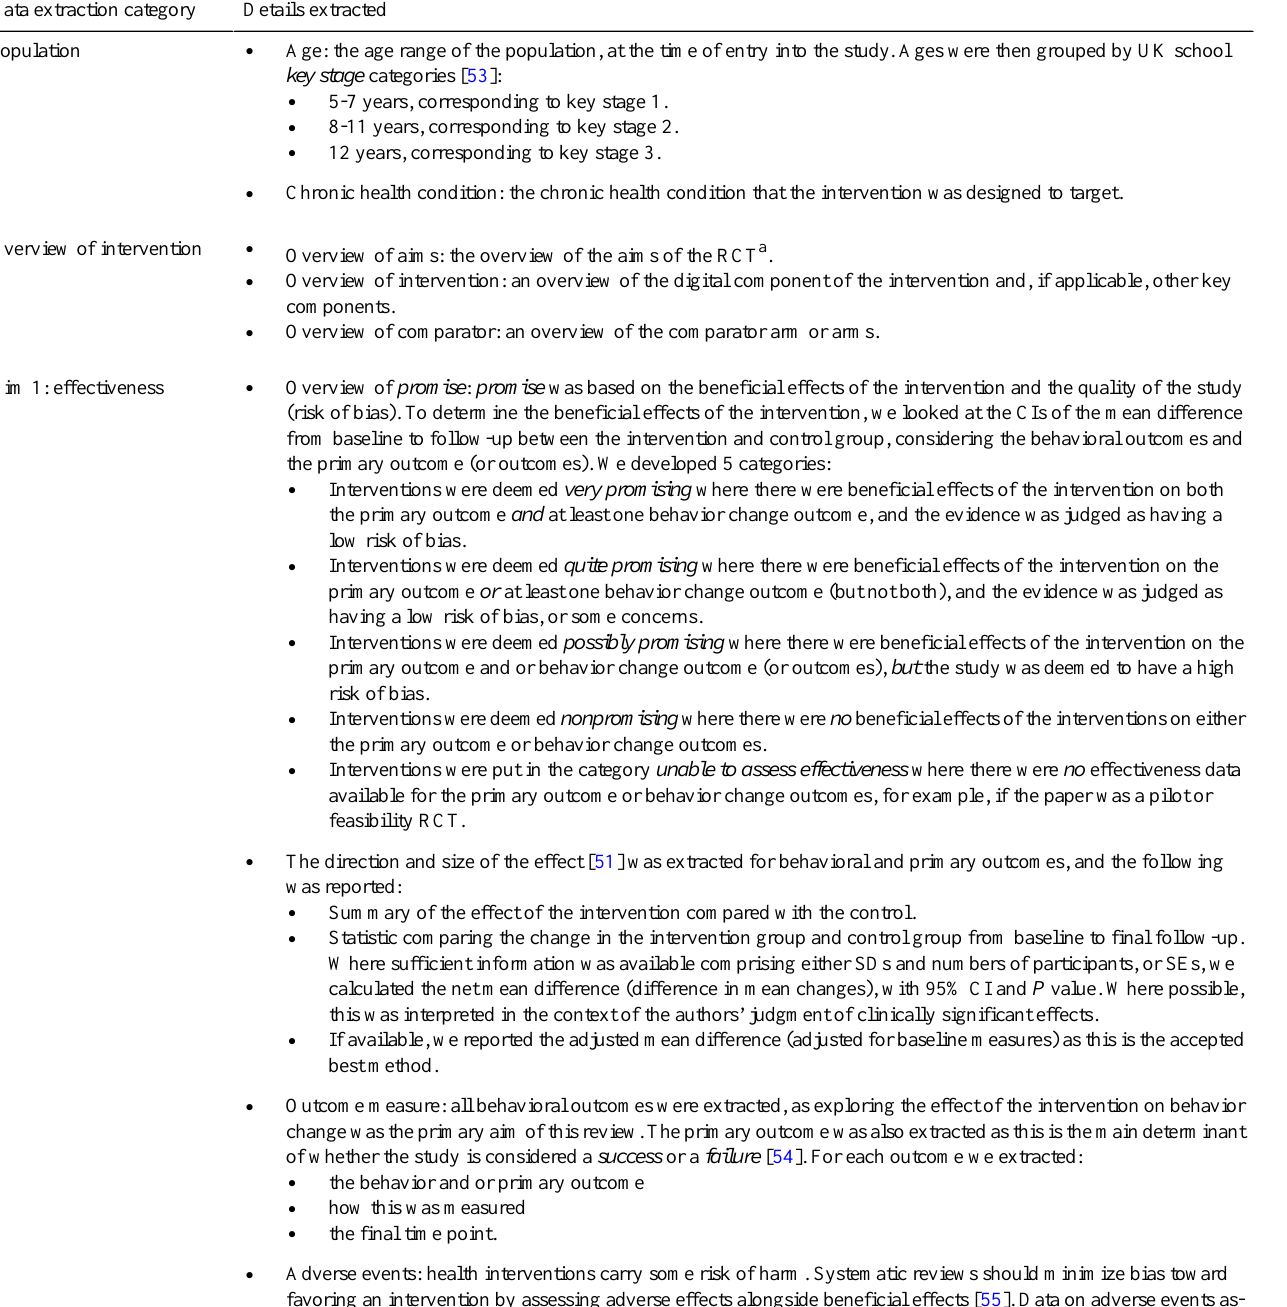
Table 1. Data extraction.